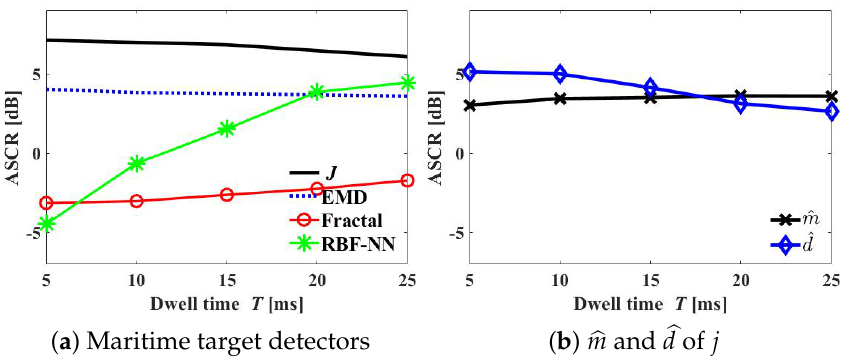
Figure 7. Mean value of ASCR versus T using all datasets.